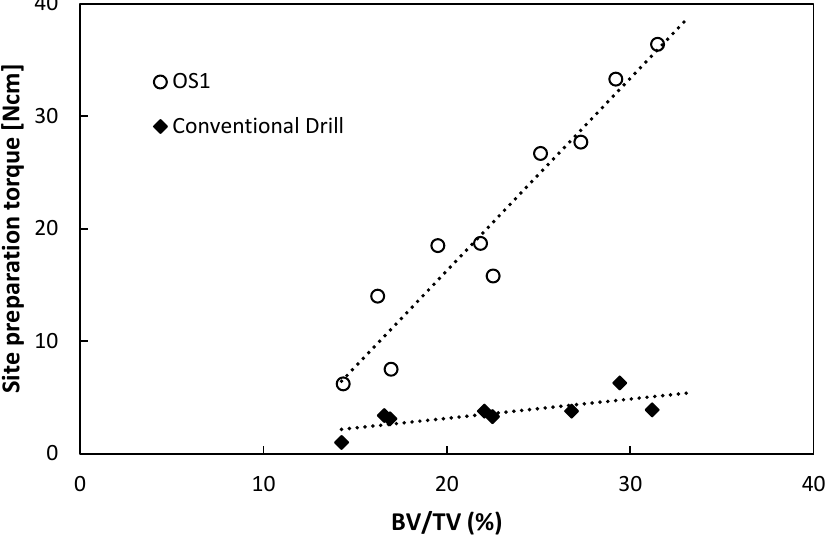
Figure 3. Linear regression of site preparation OS1 in bovine samples ( n = 10) and of conventional drill ( n = 8) with bone volume fraction (BV/TV) .